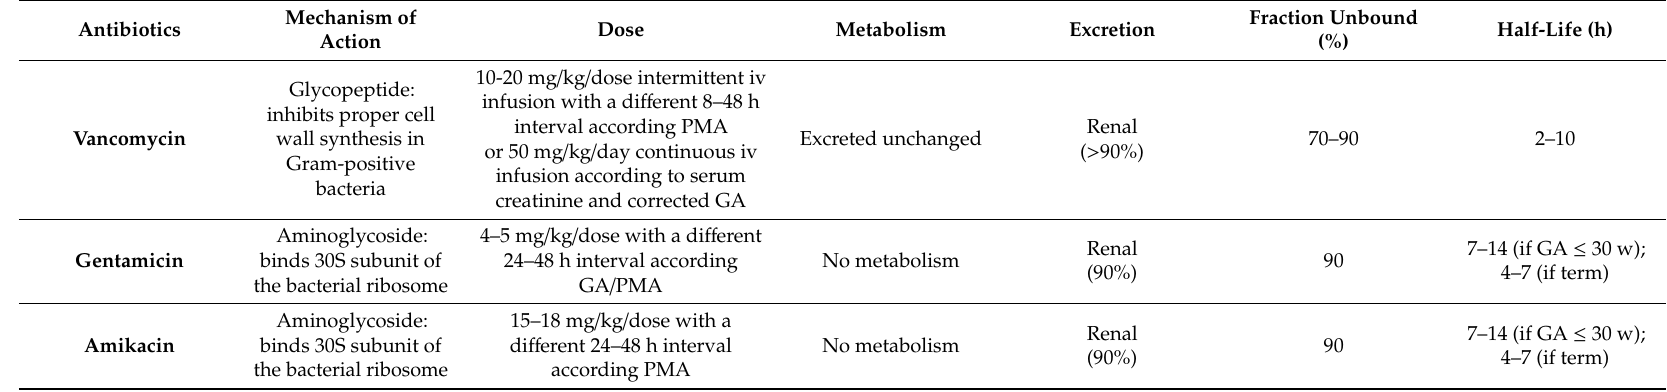
Table 1. Pharmacokinetics of most common antibiotics titrated with TDM in newborns (modified from Rybak et al. [72] and Huttner et al. [73]). iv,